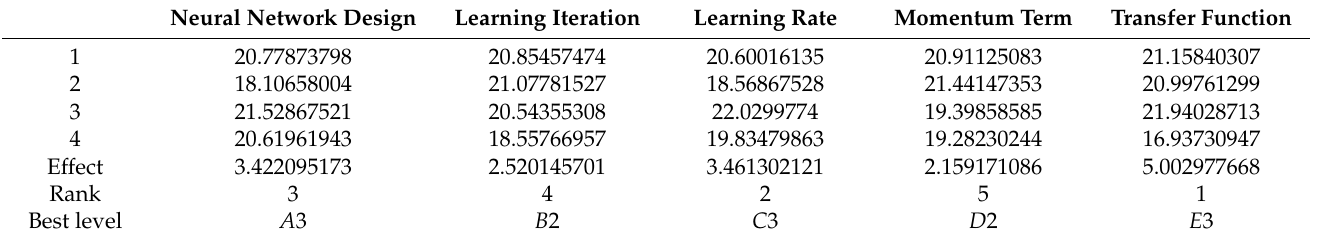
Table 9. S/N ratio factor response list.